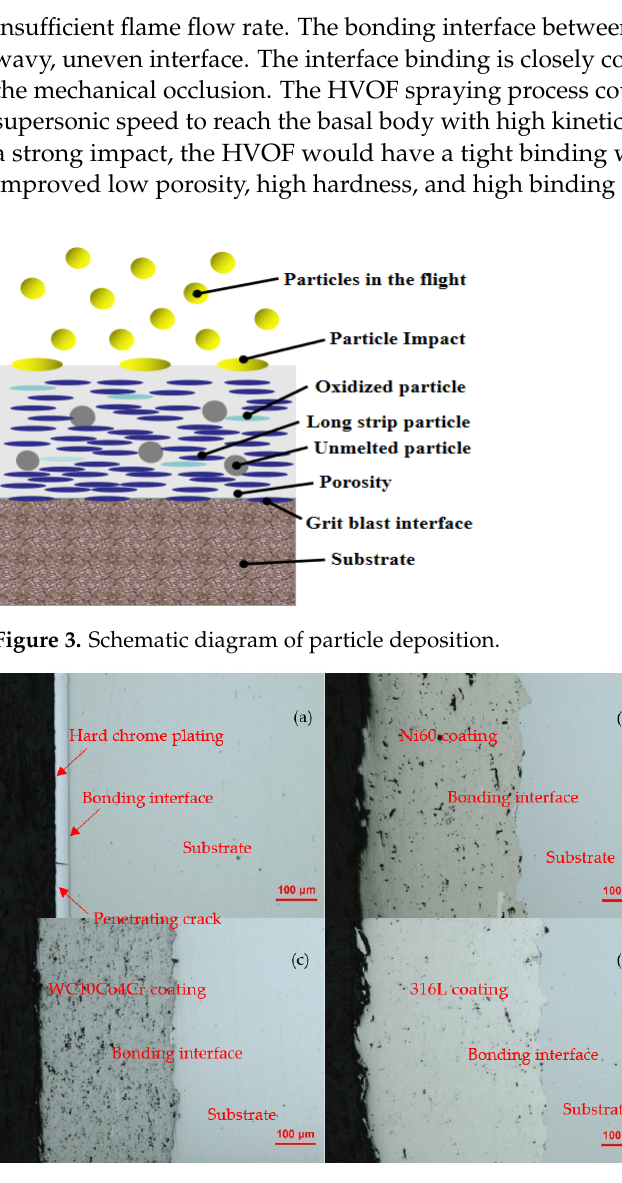
Figure 3. Schematic diagram of particle deposition.